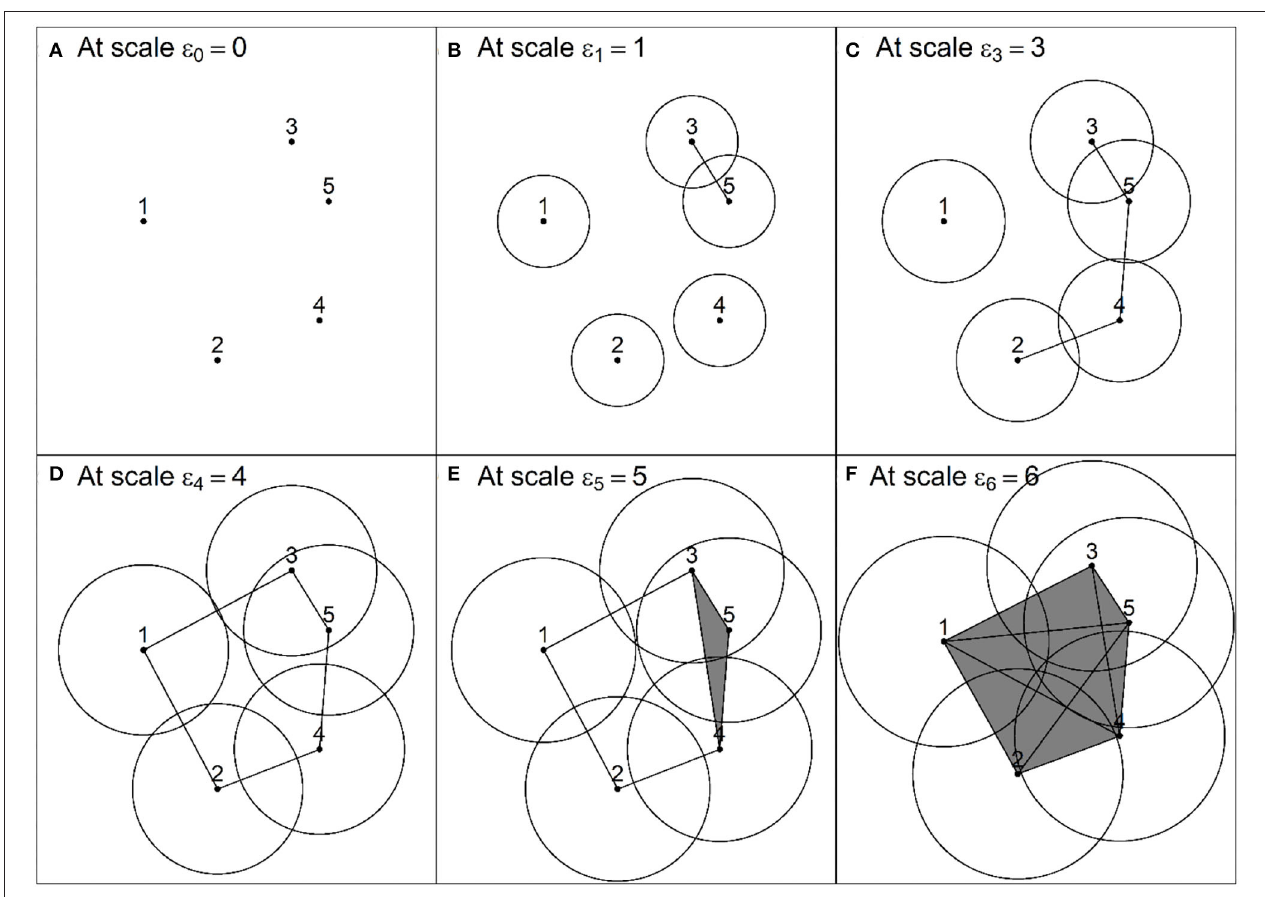
FIGURE 2 | Filtration of six Rips complexes constructed of a PCD at six different